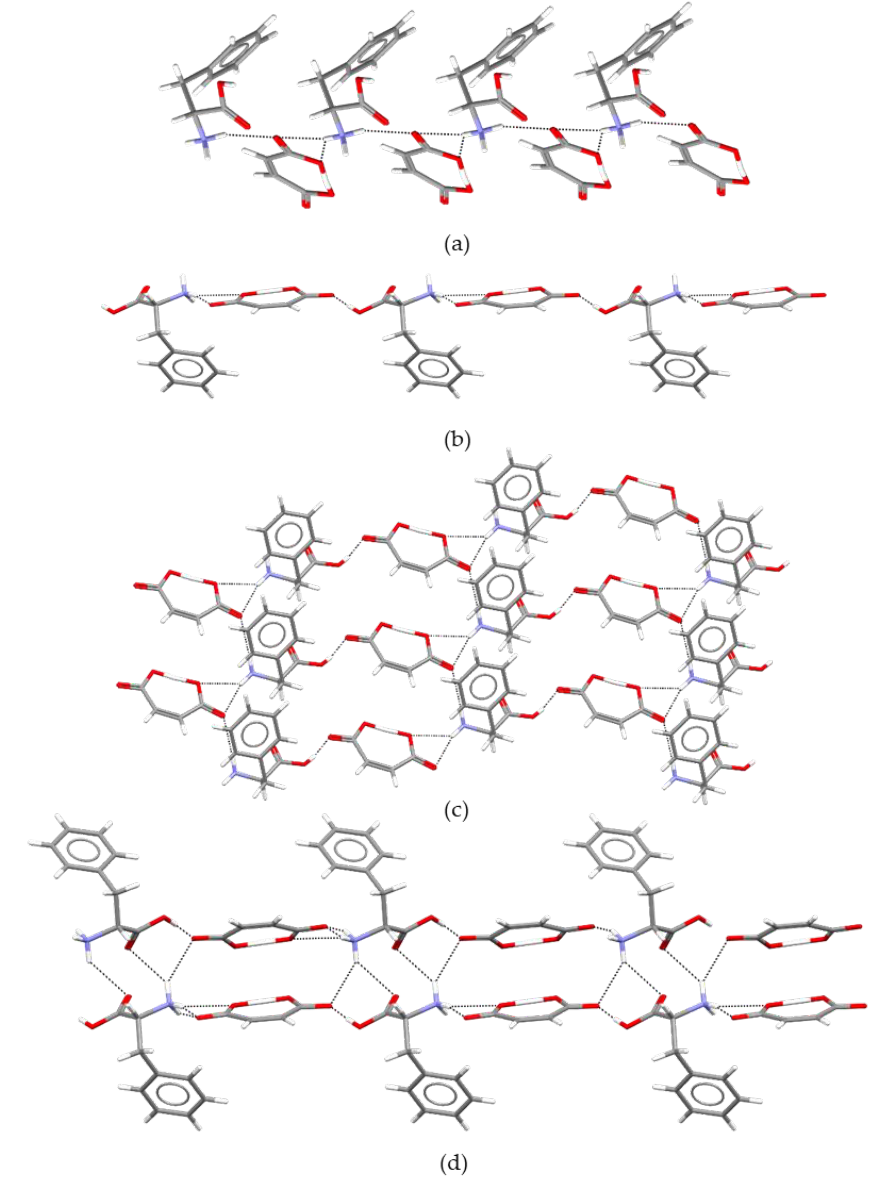
( 4 ) chain; (4) C 2 2